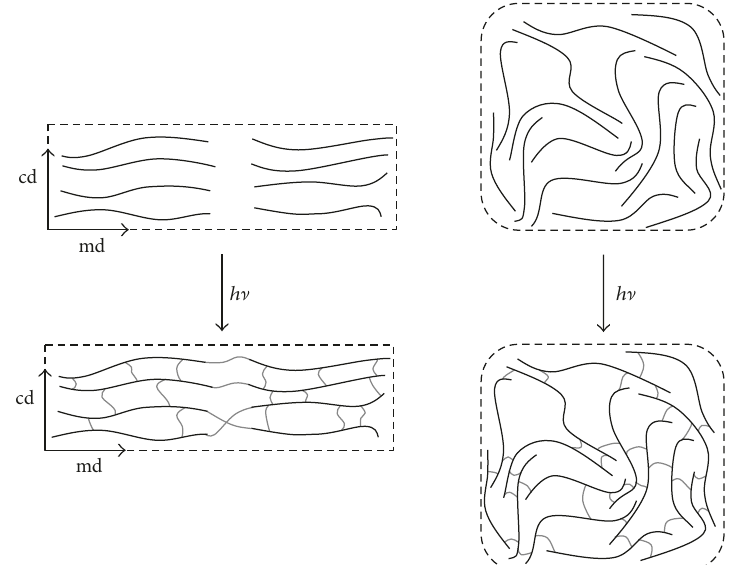
Figure 3: Film morphology of WPSS coatings (cd: cross direction; md: machine direction; adapted from Schmid et al. [12]) and cast films after UV radiation; the figure shows the additional covalent intermolecular interactions induced by UV radiation; disulfide bonds are not shown.